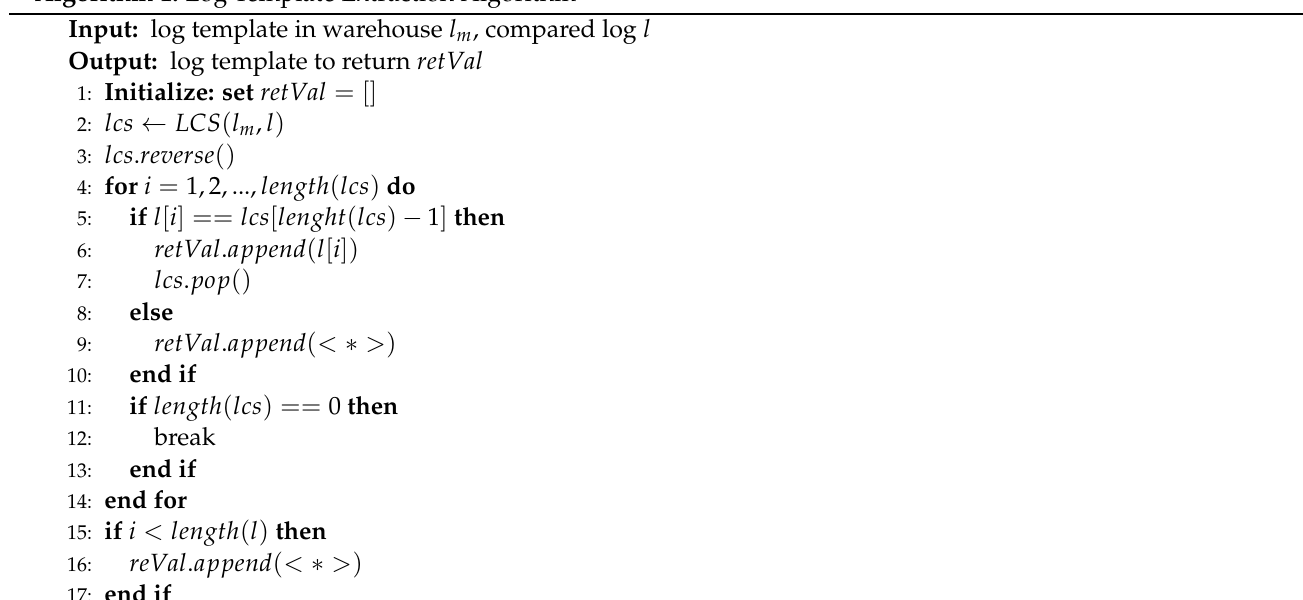
Algorithm 1: Log Template Extraction